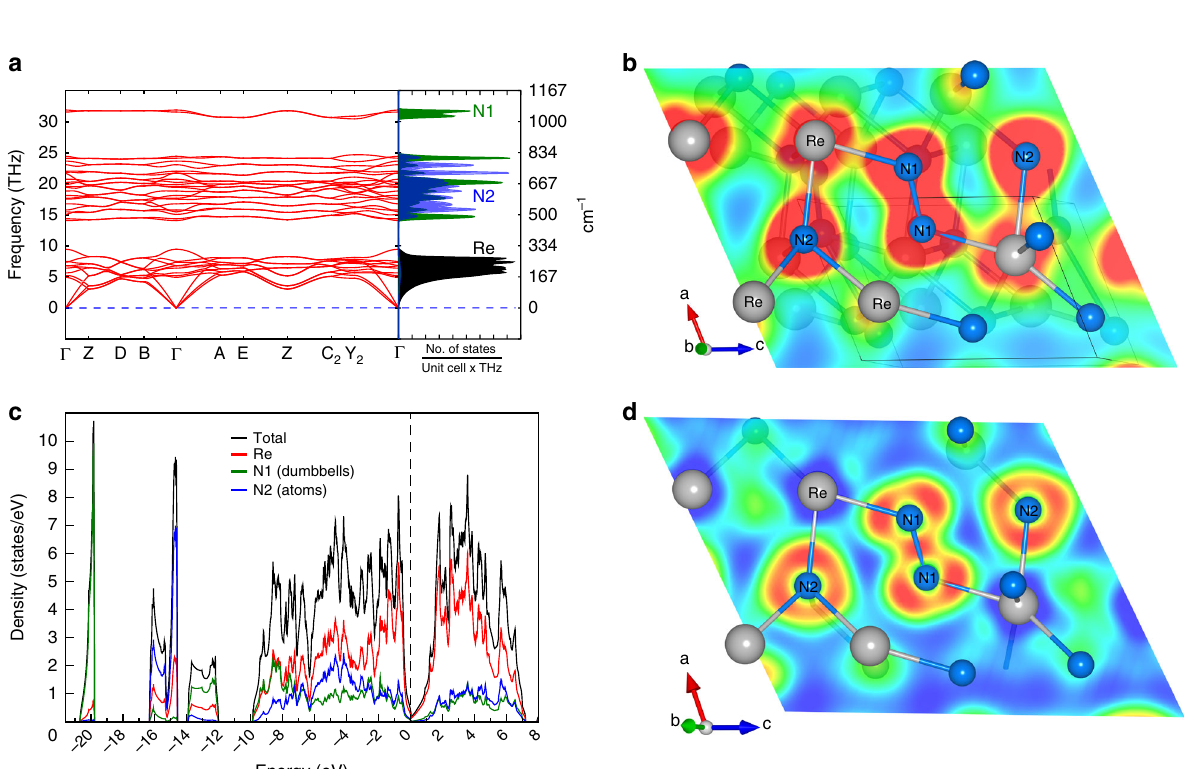
Fig. 3 Phonon and electronic structure calculations for ReN 2 . Calculated phonon dispersion relations ( a ), charge density map ( b ), densities of states ( c ), and electron localization function ( d ) for ReN 2 at ambient conditions